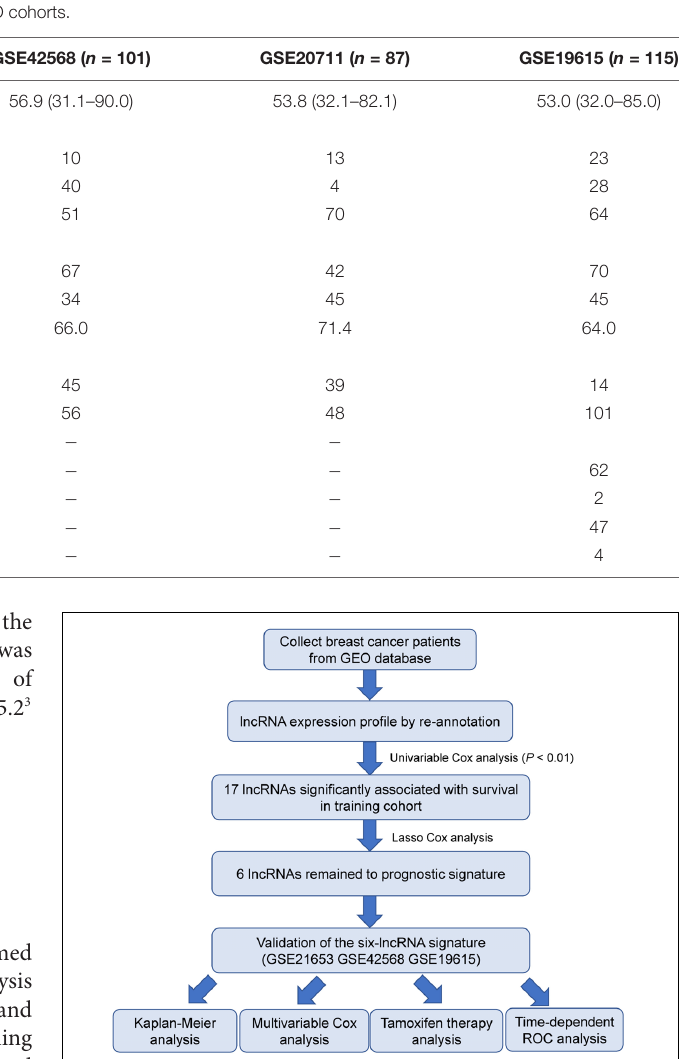
FIGURE 1 | The workflow of identification and validation of the six-lncRNA